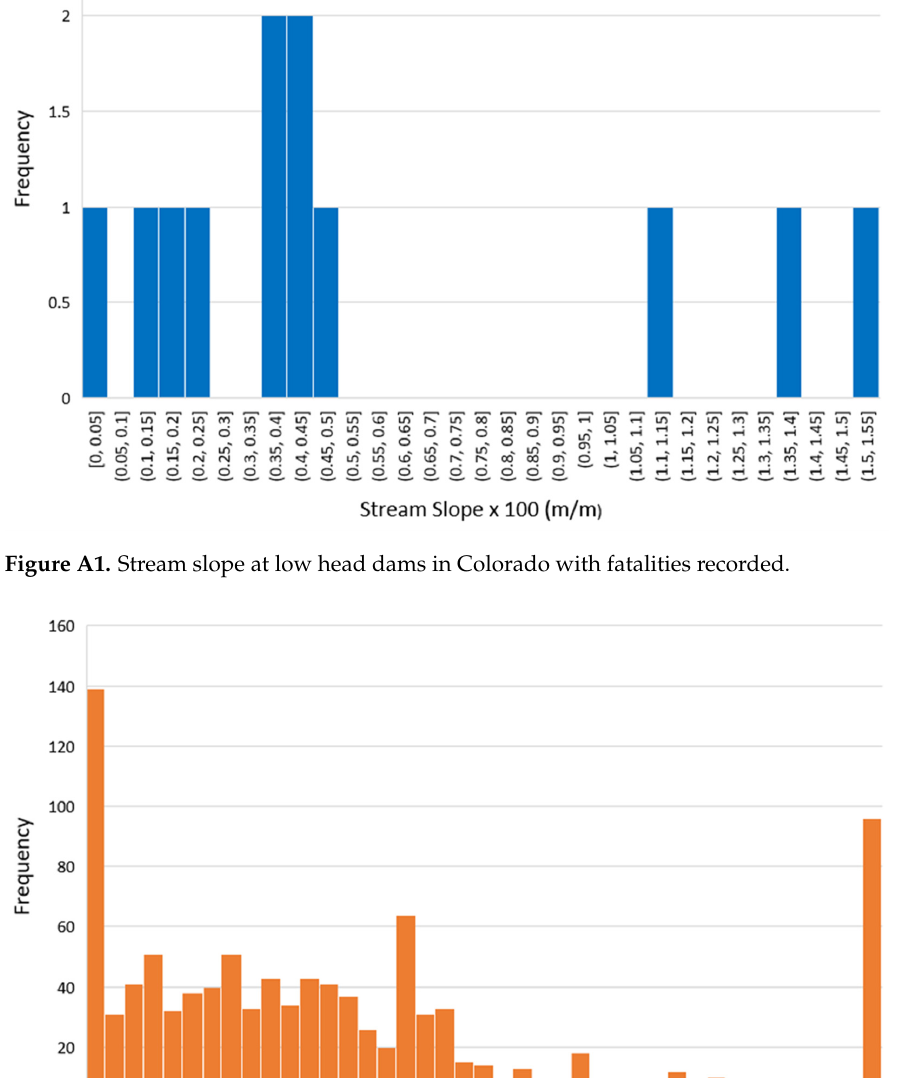
( b ) Figure A3. Stream slope at low head dams (LHDs) in Colorado: ( a ) box and whisker plot cutting off the outlier points for low head dams with no recorded fatalities ( b ) The same plot showing the whole range of outlier points for both distributions. Indiana Results: